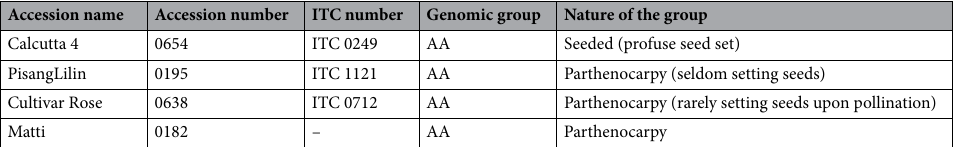
Table 3. Accession number, genomic and parthenocarpic nature of the accessions used in the study.